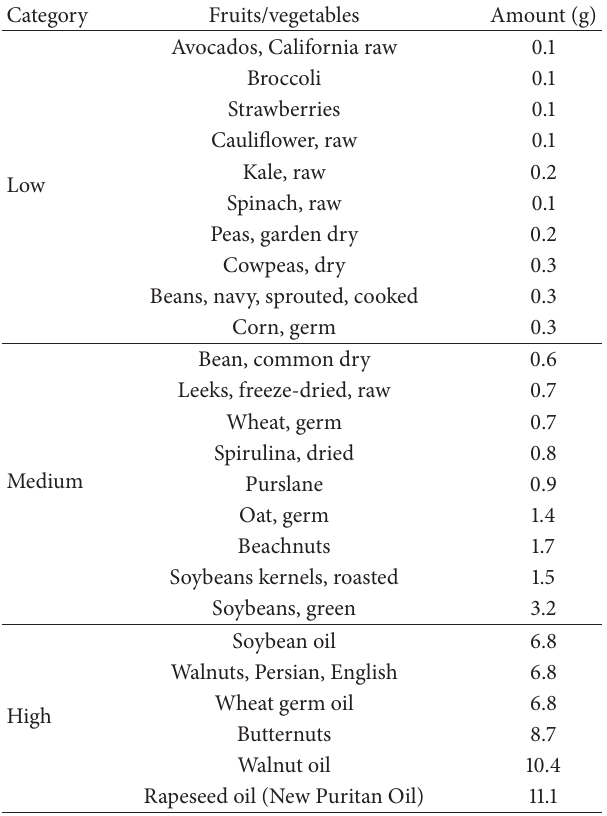
Table 1: Purslane ( Portulaca oleracea ) (Nutritive value per 100 g). Table 2: Plant sources of omega-3 fatty acids (g/100g). Category